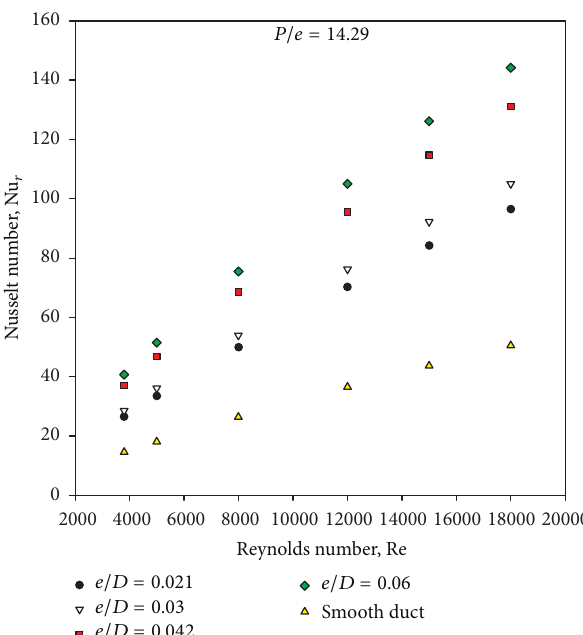
Figure 5: Variation of average Nusselt number enhancement ratio with Reynolds